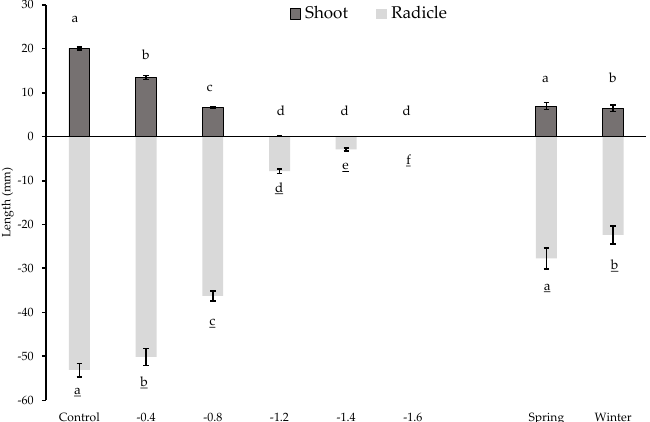
Figure 3. Shoot and radicle lengths of camelina (mm) in response to the main effects: osmotic stress (Control = 0, − 0.4, − 0.8, − 1.2, − 1.4 and − 1.6 MPa) and biotype (winter and spring). Mean values ± SE. Different standard letters: statistically different means within the same main effect for p ≤ 0.05 (LSD’s test) for shoot length. Different underlined letters: statistically different means within the same main effect for p ≤ 0.05 (LSD’s test) for radicle length. Radicle length is reported graphically as a negative value, but it corresponds to the mean of the surveyed values.